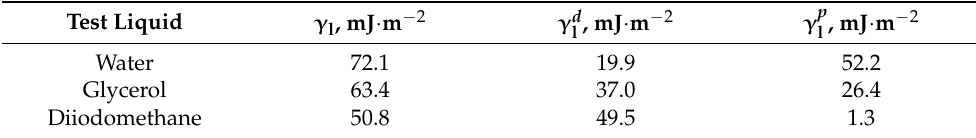
Table 1. The surface tension values (overall, dispersive and polar) of the test liquids. Test